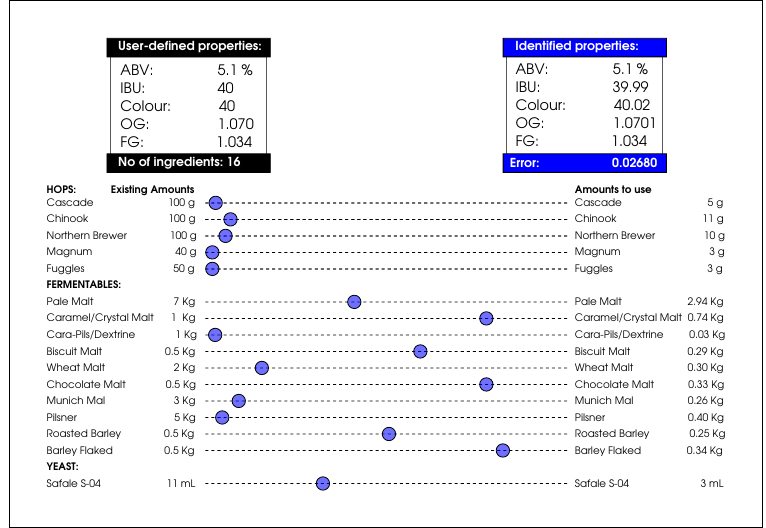
Figure 1. Brewing process optimisation: a schematic view. Users’ desired values are provided to the system using the control panel on the top-left corner. The corresponding optimal values, found based on the ingredients in the inventory, are reflected in the top-right panel. The dashed lines represent each of the in-stock ingredients, and the circles indicate the suggested quantities to use by the